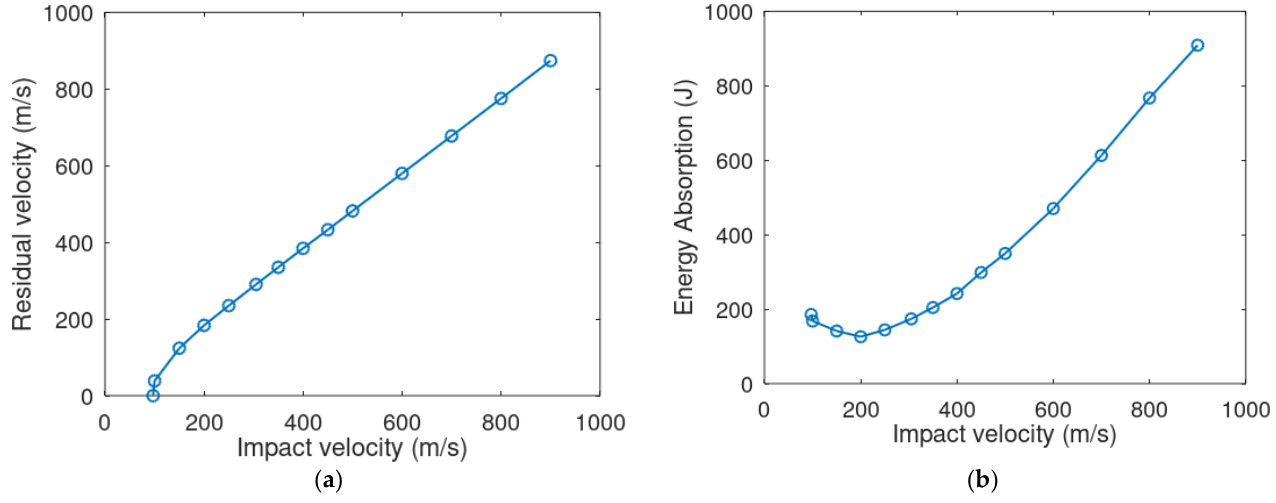
Figure 13. ( a ) Residual velocity vs. impact velocity. ( b ) Energy absorption vs. impact velocity for the 4 mm target thickness .